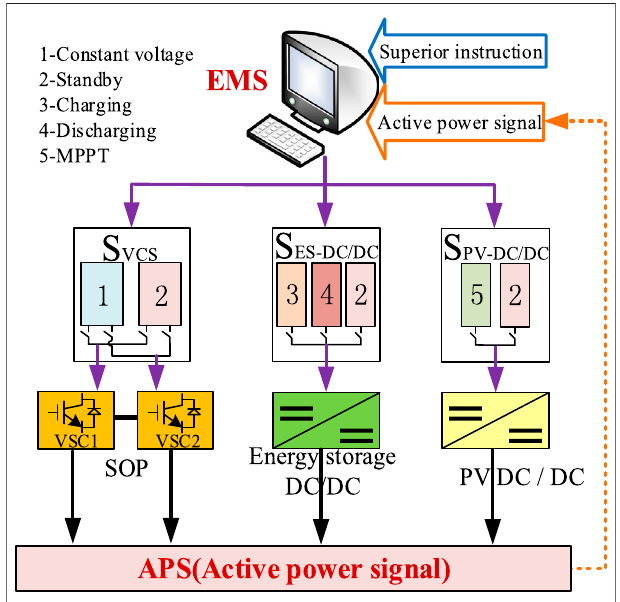
FIGURE 3 | Coordination control strategy of multi-station